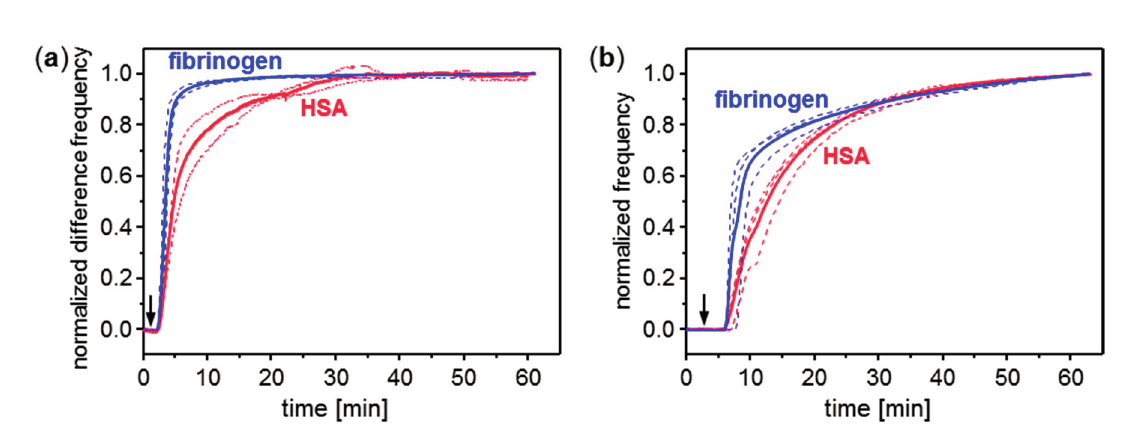
Figure 8. Conditioning film monitoring with ( a ) SAW resonators and ( b ) QCM sensors coated with parylene C: normalized frequency curves (dashed lines) obtained by adsorption of plasma proteins HSA (red curves) and fibrinogen (blue curves). Solid lines represent average curves. Samples contained 250 µg/mL protein in PBS. The PBS carrier stream was switched to sample solution (a) 1 min and (b) 3 min after start of the measurement (see